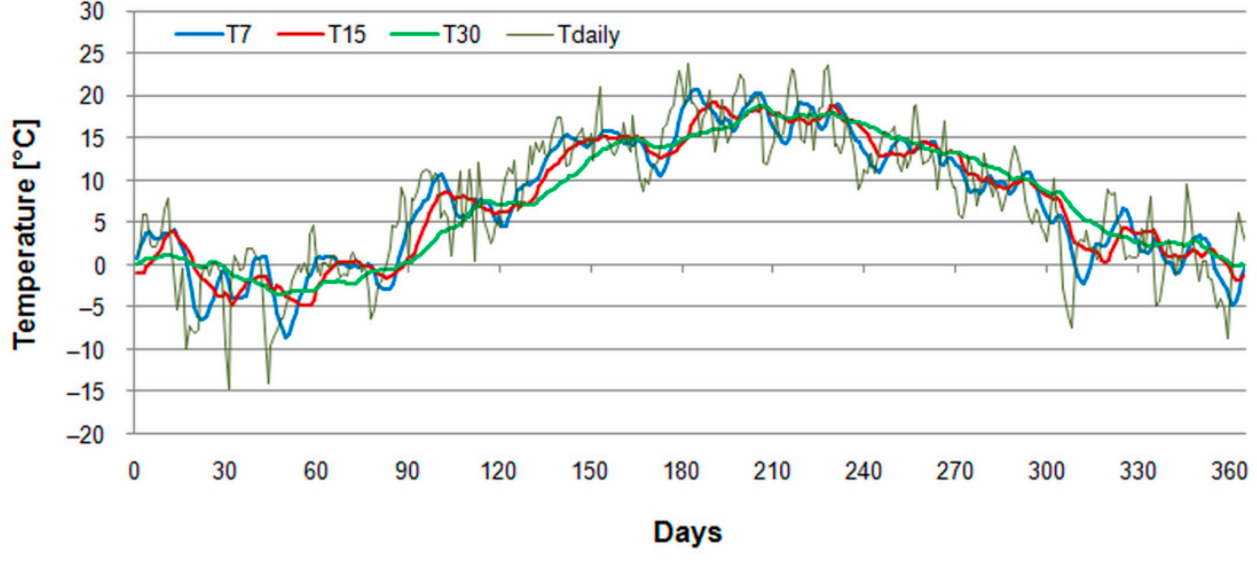
Figure 4. Daily mean outdoor temperature and running mean outdoor temperature as the arith- metic mean.